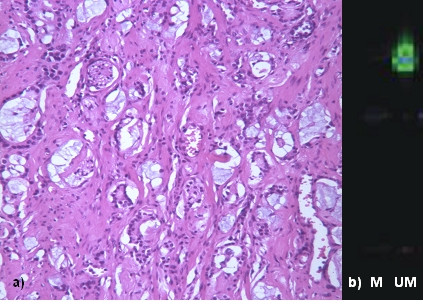
a) Radical prostatectomy specimen of the same patient after NHT showing adenoacarcinoma with moderate regressive changes (H&E staining). b) GSTP1 promoter methylation analysis of the tumor displaying only unmethylated (UN, 99-bp product, green fluorescence) GSTP1 promoter sequences. Methylated GSTP1 promoter sequences (M, 92-base pairs (bp) product, blue fluorescence; tumor DNA) are lacking.